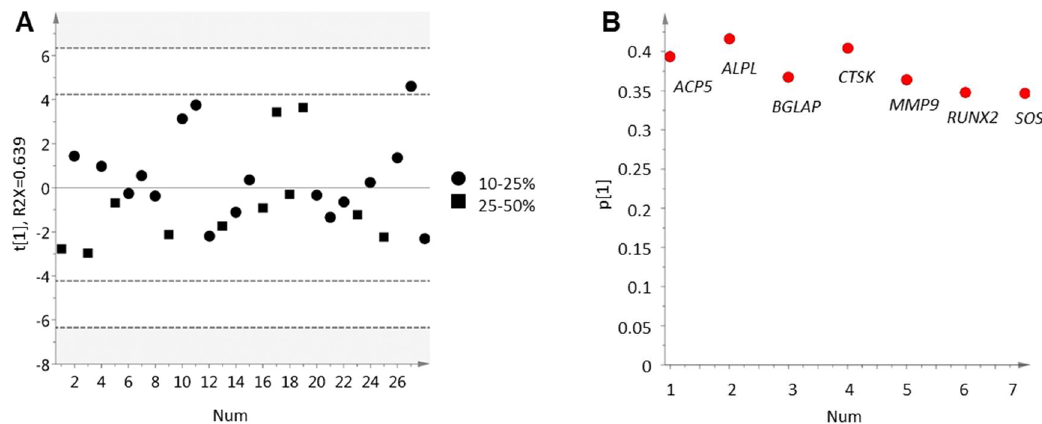
Figure 1. Principal component analysis of seven assigned gene products associated with bone cell activity in 28 bone metastases samples. ( A ) score plot for the first principal component. Each dot corresponds to one metastasis sample collected from prostate cancer patients. Bone content was determined within the range of 10–25% or 25–50% by histological examination of tissue sections; ( B ) loading plot showing included gene probes. Positive loading values ( p ) represent genes expressed at high levels in samples with positive score values ( t ) and vice versa.